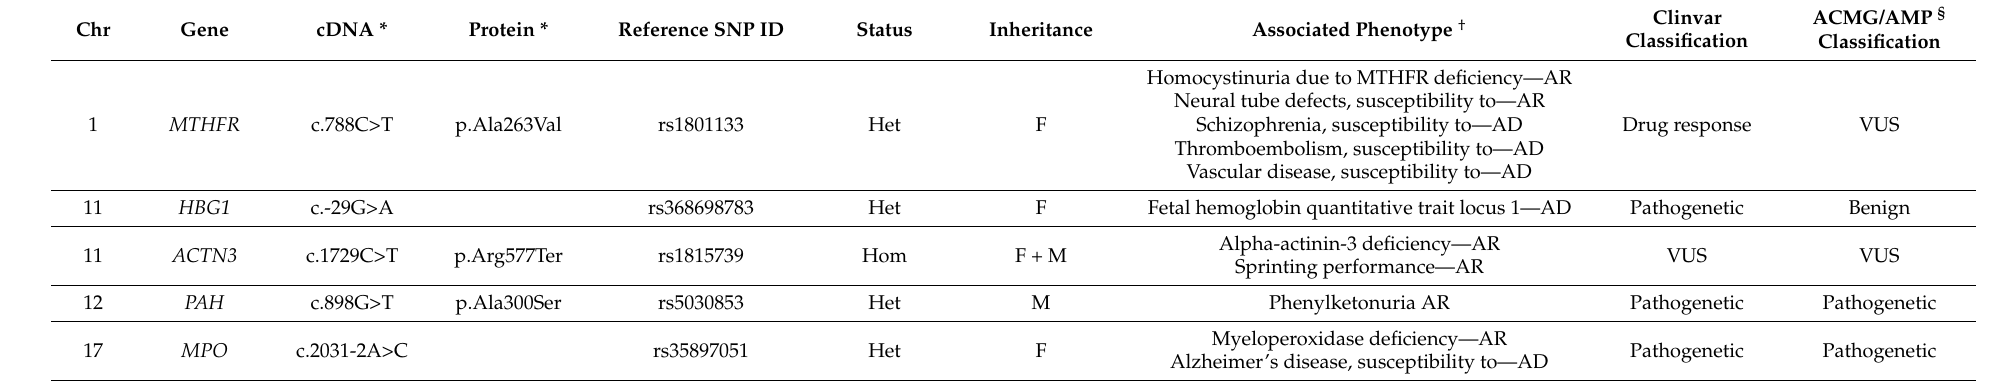
Table 1. List of the potentially interesting DNA variants identified in the proband after exome sequencing data